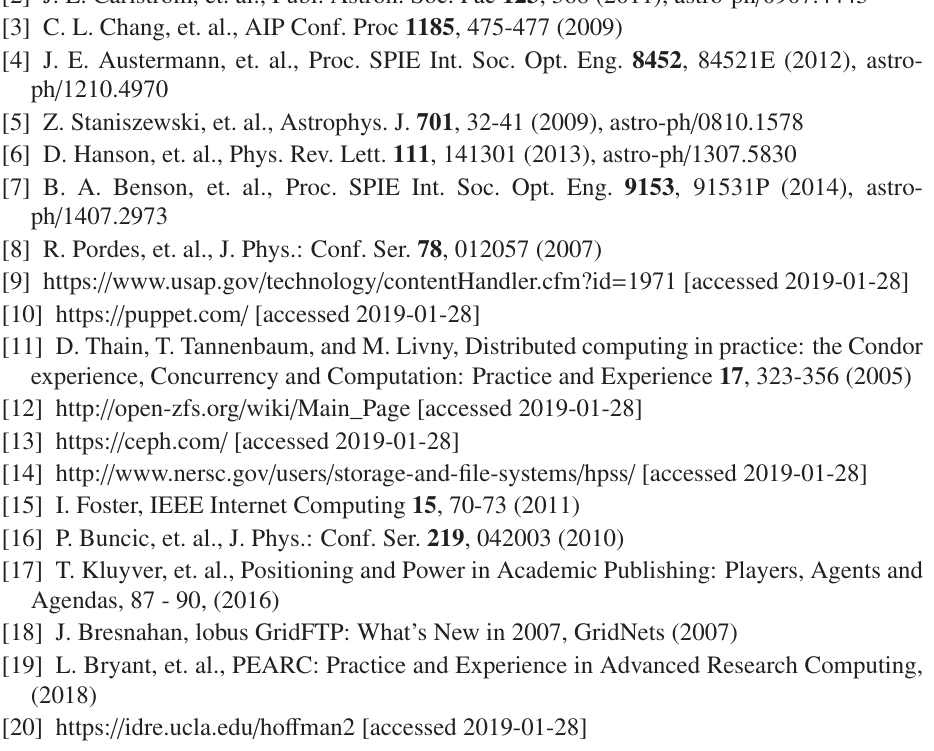
Figure 3. Summary of monthly Wall Hours used by SPT across the